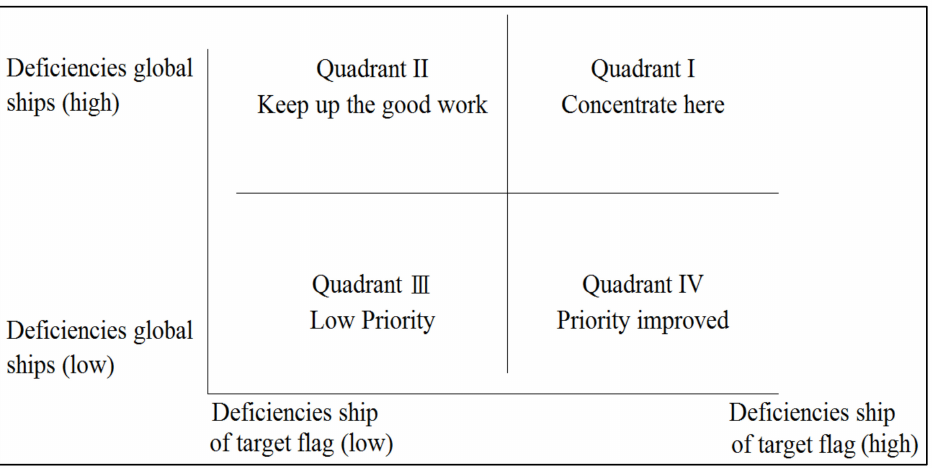
Figure 2. Updated importance-performance